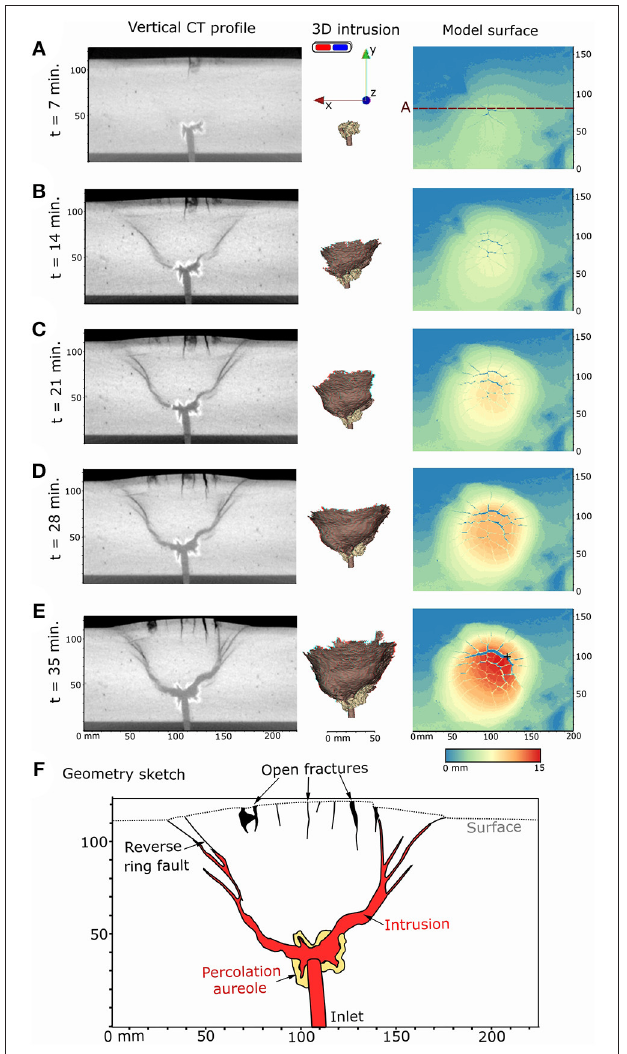
FIGURE 6 | (A–E) Temporal evolution of a cone sheet intrusion in a 80:20 wt% sand:plaster mixture (SPCTIN06 in Table 2 ); (Left column) vertical x-y slice of reconstructed CT volumes through the model center; (Central column) 3D anaglyphs of the intrusion rendered from CT images, to be viewed with blue-red 3D glasses; (Right column) Model surface elevation extracted from resampled CT images, the black cross marks where syrup broke through the surface (i.e., eruption); (F) Structural sketch of the final intrusion and induced deformation structures in the overburden through the central x-y slice in (E) ( t = 35min).